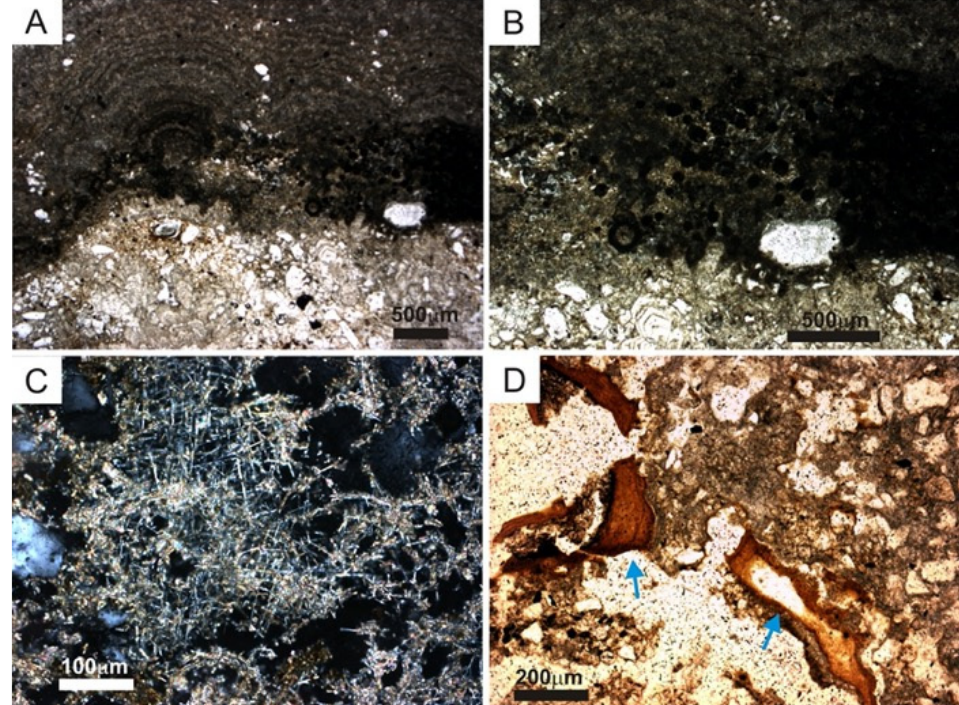
Figure 10. Microphotographs of feature characteristics of micritic crusts: ( A , B ) compact micritic crust composed of the alternation of dense and clotted laminae, with details of peloidal structures (Sample 304); ( C ) NFC crystals in a random aggregate (Sample 696); ( D ) laminar and discontinuous clay (hypo-) coatings (arrows) (Sample 696). Microphotographs ( A , B , D ) were taken under plane-polarized light; ( C ) was taken under crossed nicols.